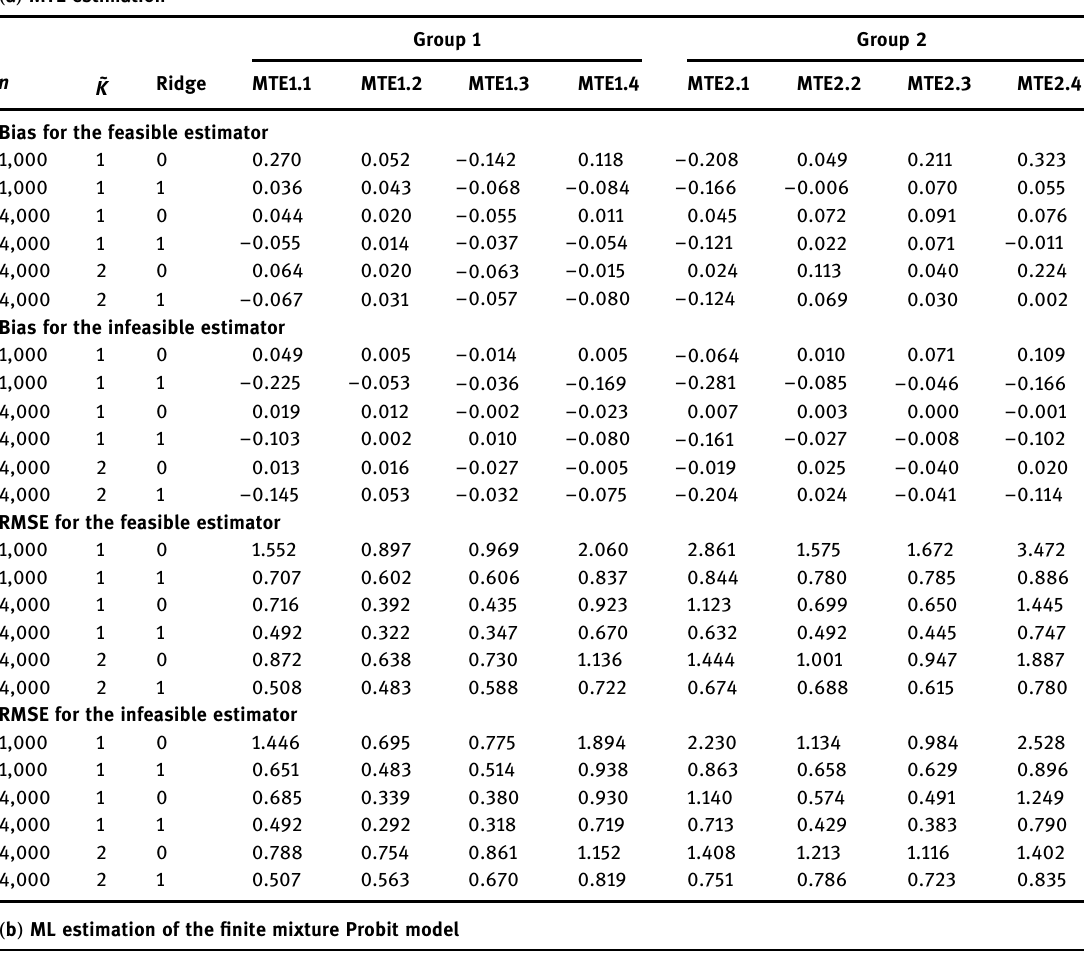
Table 1: Simulation